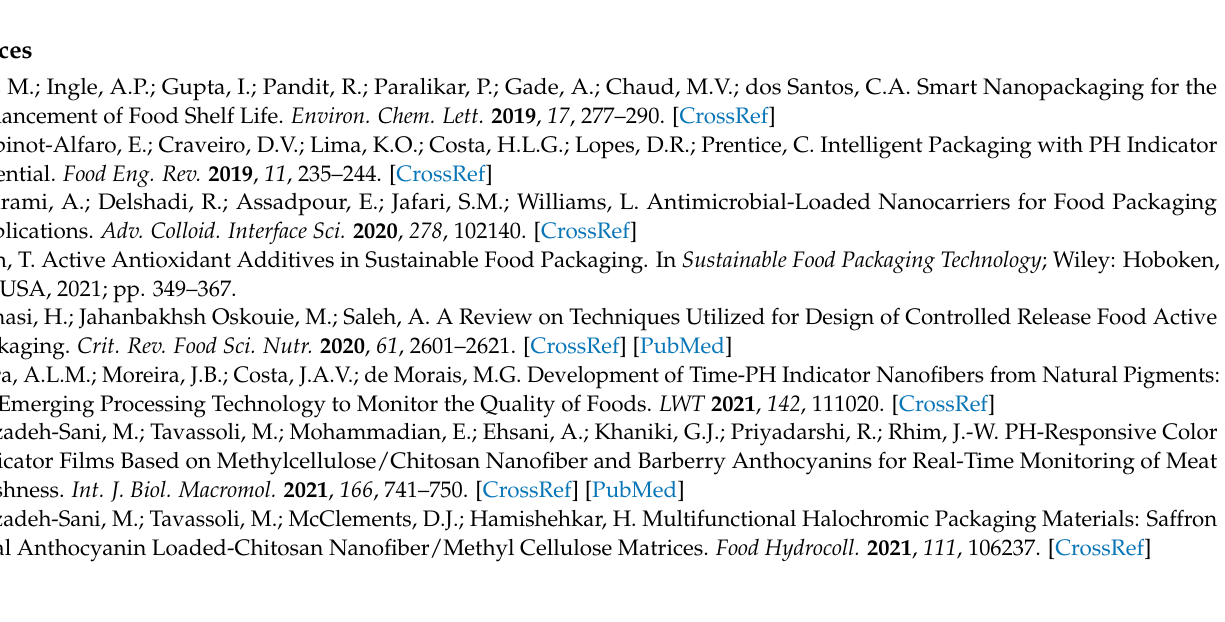
studentized residuals, Figure S2: Plots of actual vs. predicted K / S , for each pigment, Figure S3: Contour and 3D response surface plots for interactive effects of variables on the K / S of violacein pigment, Figure S4. Contour and 3D response surface plots for interactive effects of variables on the K / S of prodigiosin pigment, Figure S5: Contour and 3D response surface plots for interactive effects of variables on the K / S of flexirubin-type